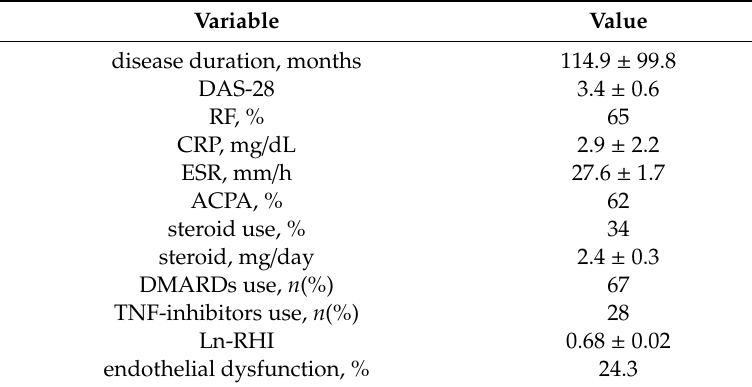
Table 2. Rheumatoid arthritis specific features and cardiovascular